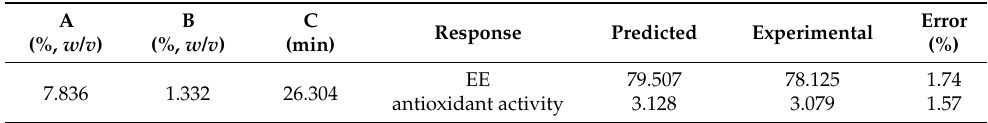
Table 5. Optimum conditions (desirability = 0.89) with the maximum predicted and experimen- tal